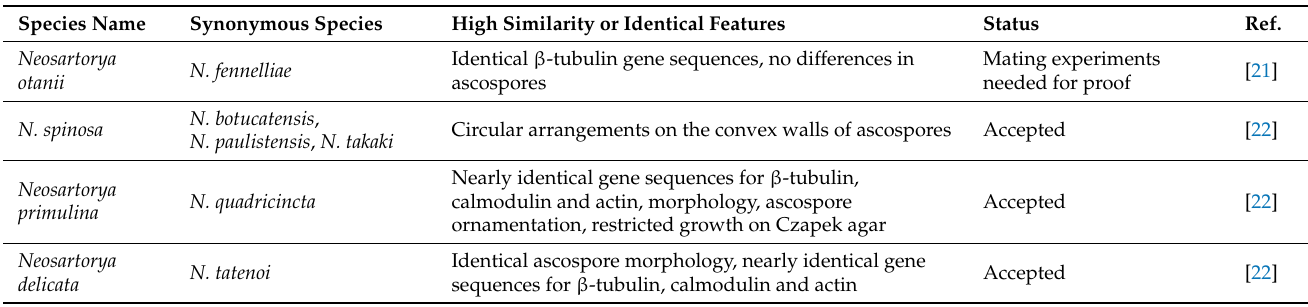
Table 1. Synonymous Neosartorya spp. species.